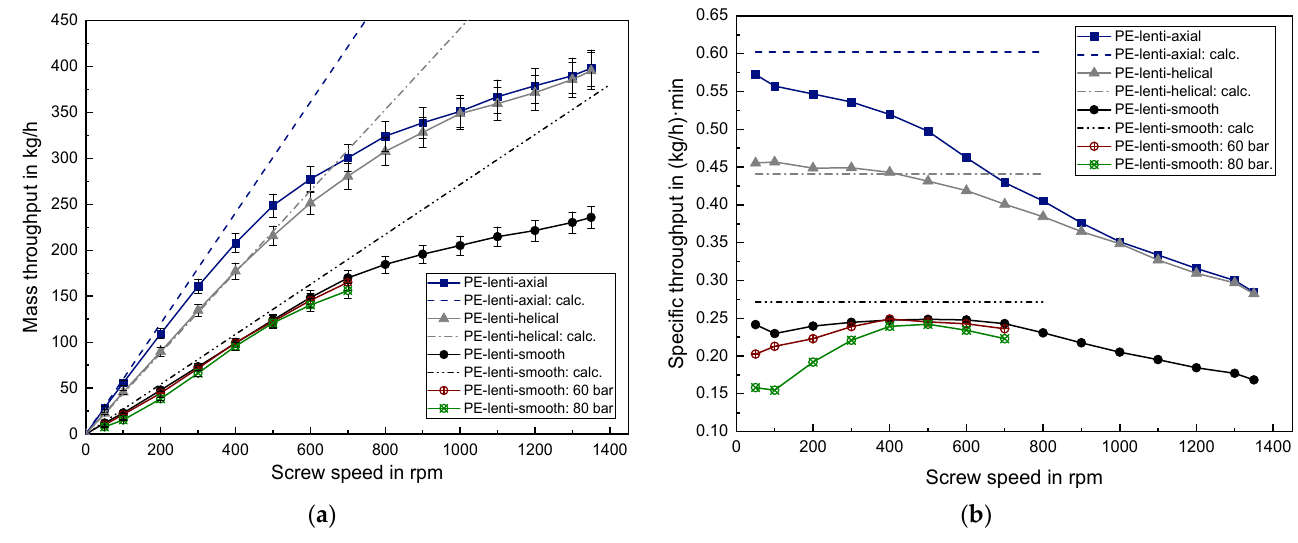
Figure 6. ( a ) Absolute mass throughput and ( b ) specific mass throughput for lenticular PE. Mounting the back pressure element onto the solid conveying zone with a smooth barrel and applying a back pressure of 60 bar and 80 bar, respectively, results in a small mass throughput decrease in the case of 60 bar and a significant decrease in the case of 80 bar, particularly at low screw speeds. Nevertheless, by exceeding 300 rpm the measured values nearly equalize. Whether this latter observation is caused by real effects or by operational uncertainties of the back pressure element must be evaluated in future work.